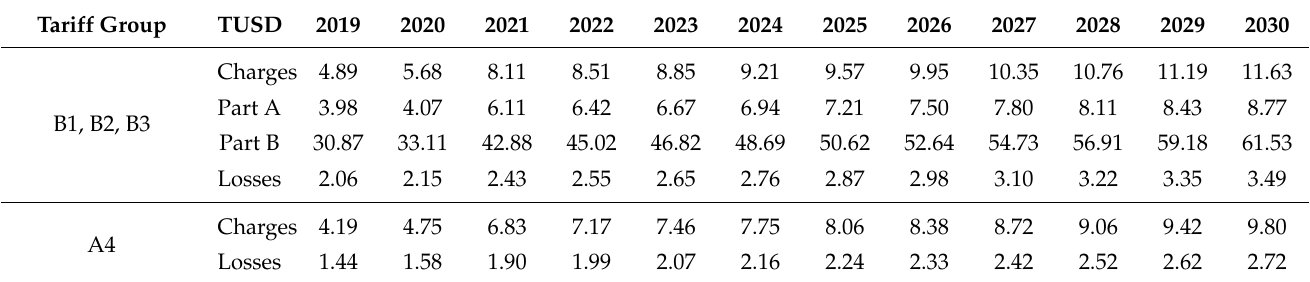
Table A5. Distribution System Use Tariffs (TUSD) by tariff group and components for Enel Cear á , in USD/MWh.